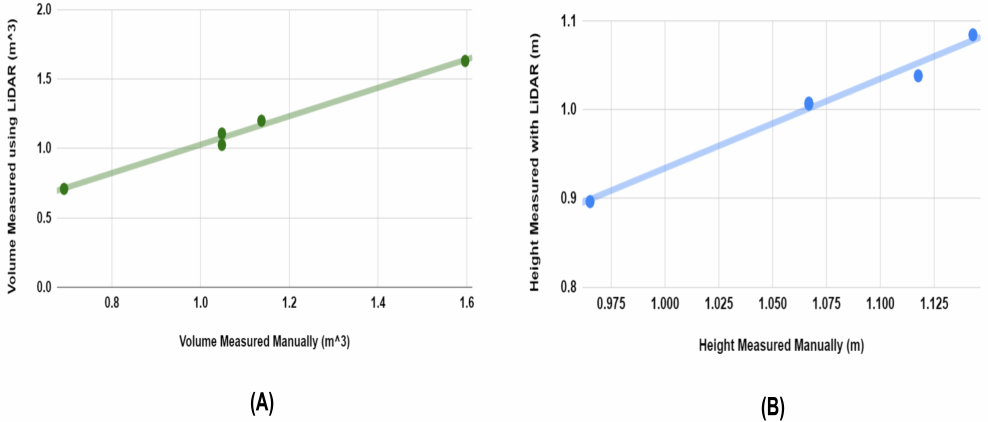
Figure 15. LiDAR phenotyping results. ( A ) Volume estimation; ( B ) Height estimation.